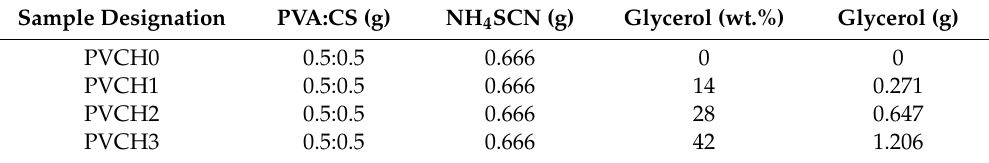
Table 1. The composition and designation of the PVA: CS: NH 4 SCN: glycrol